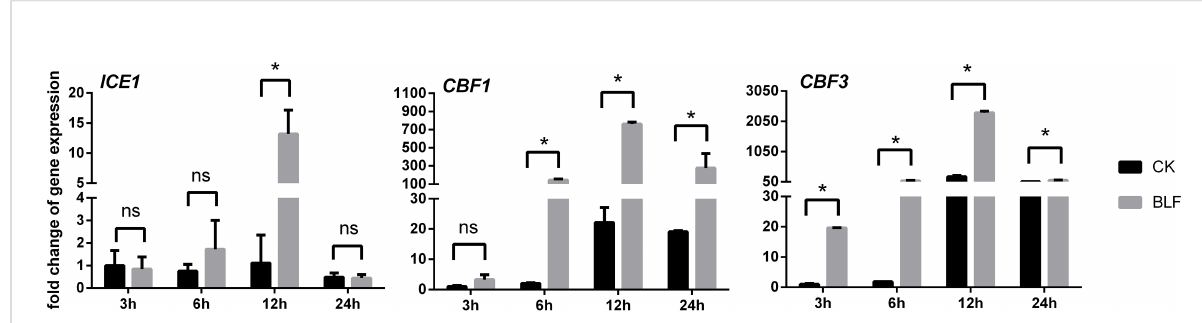
FIGURE 9 Effect of spraying BLF on the relative expression levels of genes associated with freezing tolerance. “ * ” means that the average value of each parameter is signi fi cant between the two treatments (p<0.05), and ns means no signi fi cance by Duncan ’ s multiple range test.